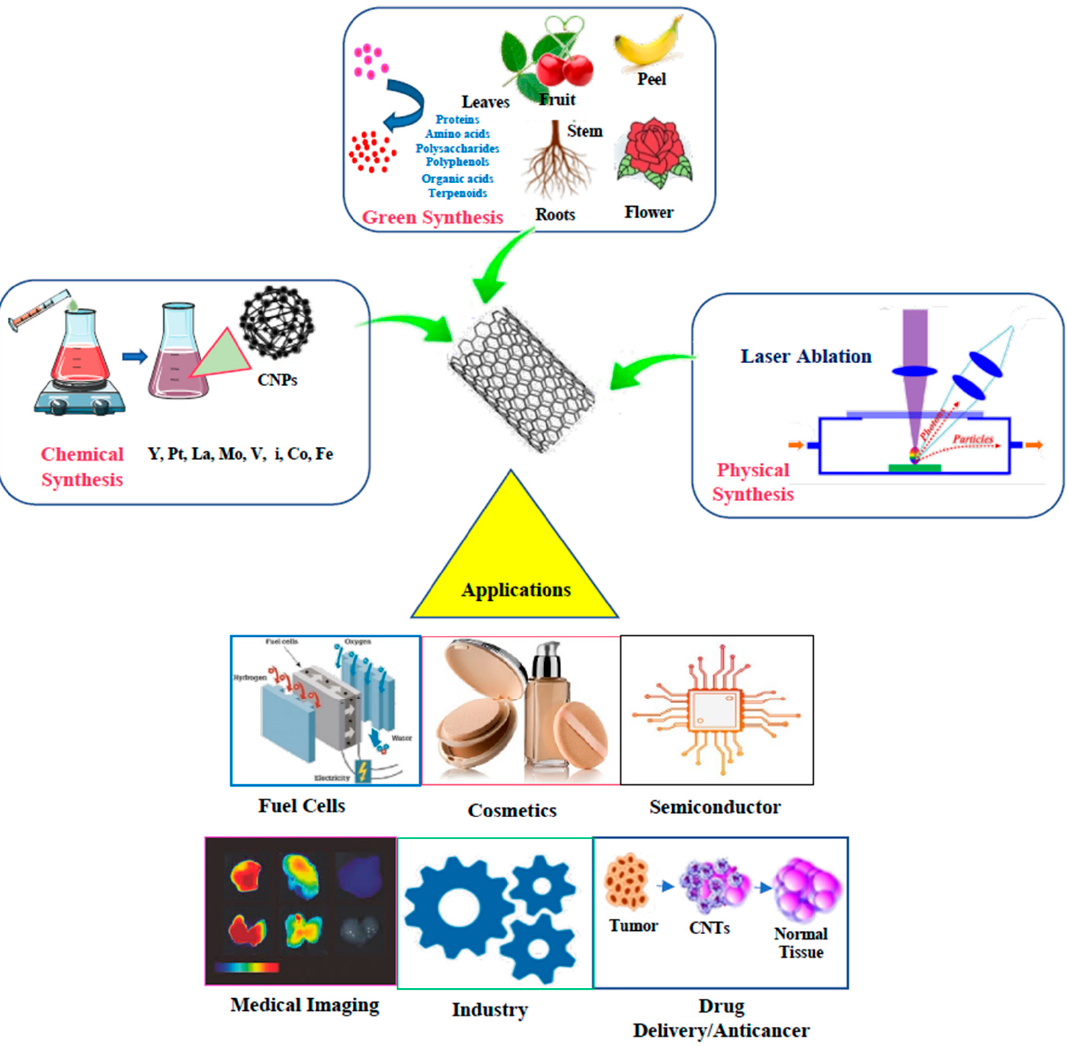
Figure 2. Types of syntheses of CNPs and example applications.